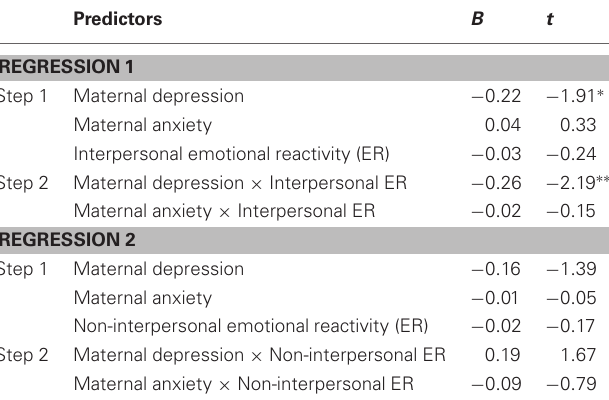
Table 2 | Predicting cognitive bias in processing of mother-relevant information.